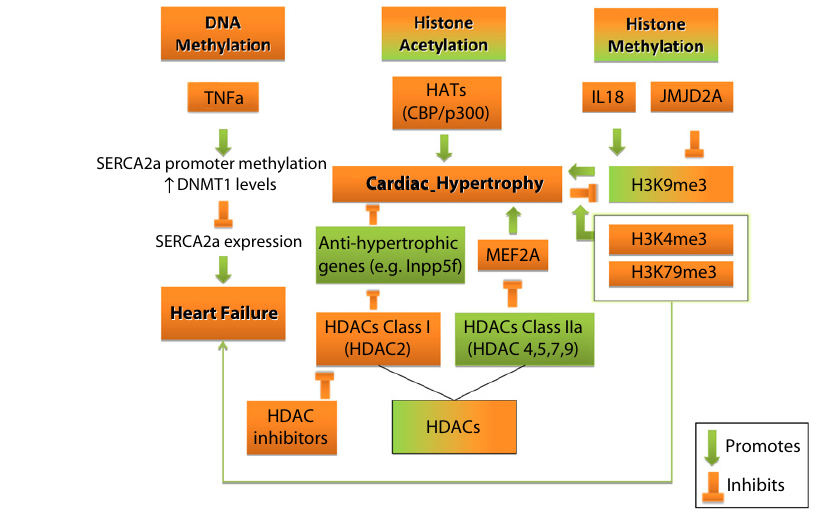
Figure 4. Diverse effects of epigenetic modifications in cardiac hypertrophy and HF. DNA methylation in specific genes contribute to HF, whilst histone acetylation and methylation are implicated in pro- and anti-hypertrophic responses and